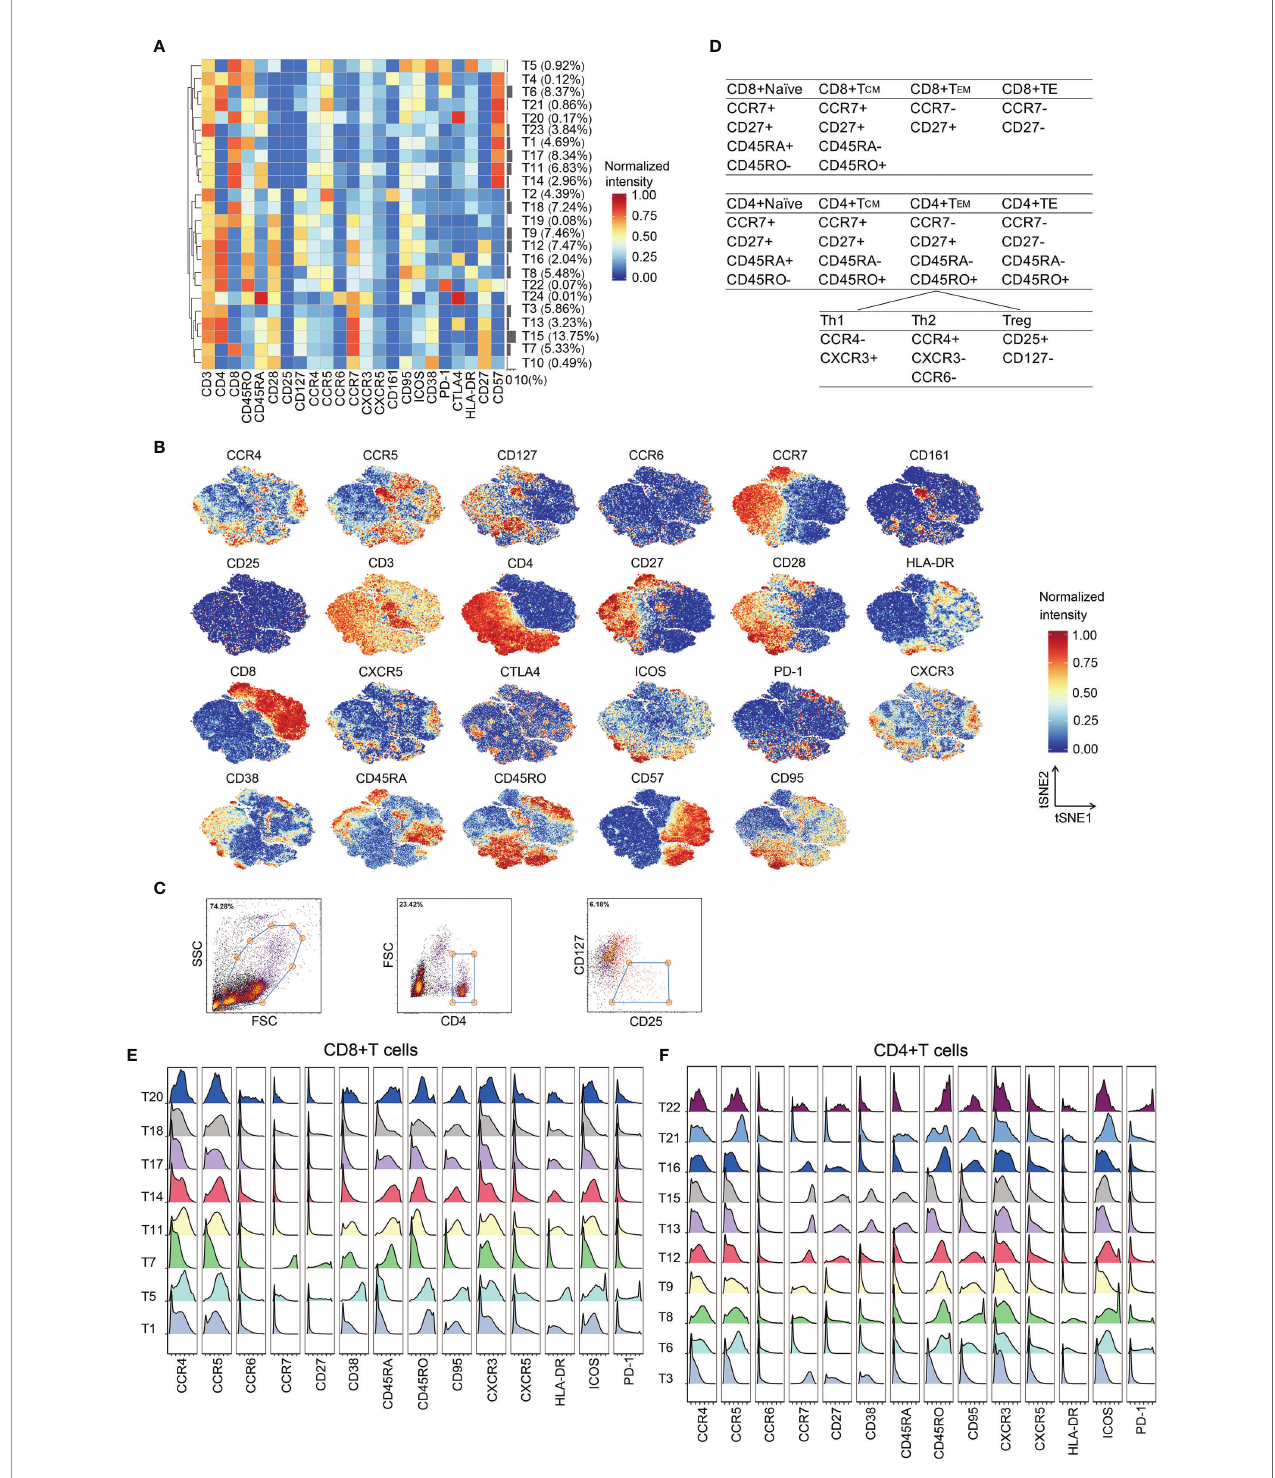
FIGURE 2 | In-depth characterization of the T cell compartment. (A) Heatmap showing normalized expression of the markers for the 24 T cell clusters. Clusters are grouped by marker expression patterns. The cluster numbers and relative frequencies are displayed on the right. (B) FIt-SNE plots of normalized marker expression for 10,000 T cells randomly selected from all patients. (C) Exemplary identi fi cation of Treg from a representative patient. PBMCs were labeled with the indicated antibodies, examined by fl ow cytometry, and then analyzed by Cytobank. The Tregs were identi fi ed through the indicated strategy. (D) Surface marker combinations used to identify T cell subsets. (E, F) Histograms showing the expression of indicated functional markers on CD8(+) T cells (E) and CD4(+) T cells (F)